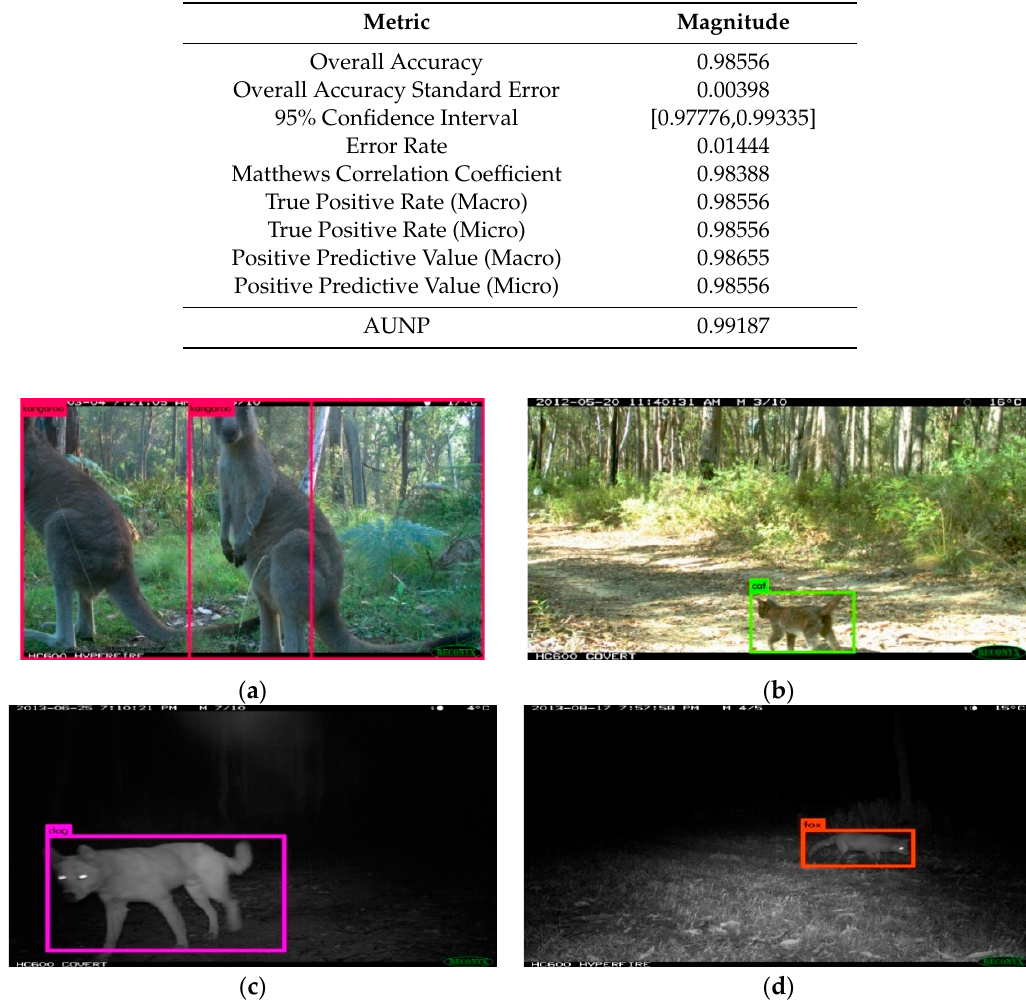
Table 4. Key Test Metrics of the New England, NSW (natural illumination) test data set. Note: AUNU denotes Area Under Receiver Operating Characteristic Curve comparing each class against rest using a uniform distribution.